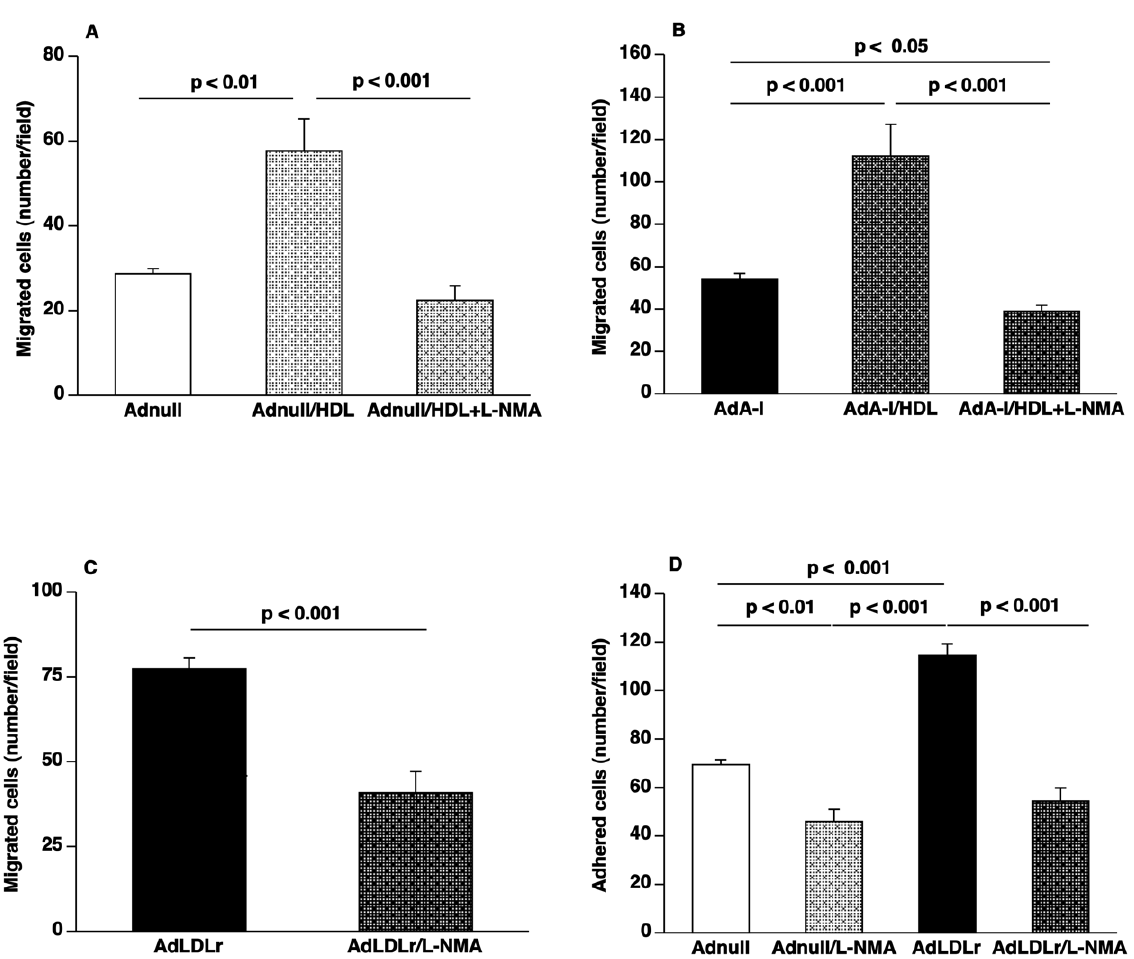
Figure 3. Potentiation of EPC function by HDL and by lipid lowering gene transfer is abrogated by the NO synthase inhibitor L- NMA. ( A ) Bar graph showing the number of migrated EPCs in modified Boyden chambers. After 7 days of culture, spleen EPCs isolated at day 14 after Adnull transfer (n=6) were seeded in the upper chamber. The lower chamber was supplemented with either bovine serum albumin (100 m g/ml) or with HDL (100 m g/ml) or with HDL (100 m g/ml) in combination with 2 m M L-NMA. The number of migrated cells per microscopy field was quantified after 5 hours. ( B ) Bar graph showing the number of migrated EPCs in modified Boyden chambers. After 7 days of culture, spleen EPCs isolated at day 14 after AdA-I transfer (n=6) were seeded in the upper chamber. The lower chamber was supplemented with either bovine serum albumin (100 m g/ ml) or with HDL (100 m g/ml) or with HDL (100 m g/ml) in combination with 2 m M L-NMA. The number of migrated cells per microscopy field was quantified after 5 hours. ( C ) Bar graph showing the number of migrated EPCs in modified Boyden chambers. After 7 days of culture, spleen EPCs isolated at day 14 after AdLDLr gene transfer (n=6) were seeded in the upper chamber. To inhibit NO synthase activity, the lower chamber was supplemented with L-NMA (2 m M) in selected experiments. ( D ) Bar graph illustrating the number of EPCs adhered to fibronectin-coated plates. After 7 days of culture, spleen EPCs isolated at day 14 after Adnull transfer (n=6) or AdLDLr transfer (n=6) were allowed to adhere onto fibronectin-coated plates for 30 minutes. To inhibit NO synthase activity, the lower chamber was supplemented with L-NMA (2 m M) in selected experiments. Following vigorously washing with PBS, the number of adherent cells was counted under the microscope. Data are expressed as means 6 SEM.